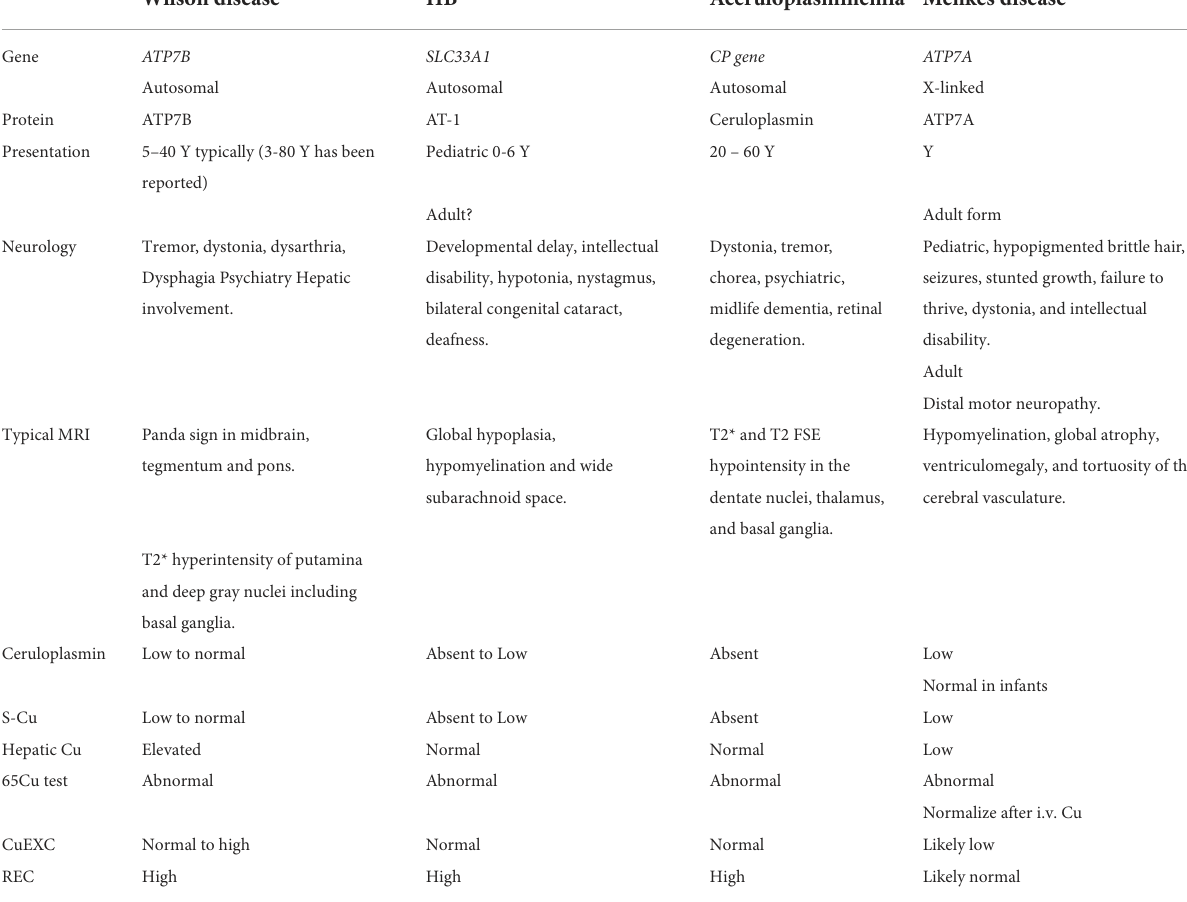
TABLE 1 Overview of Huppke–Brendel (HB) syndrome and other copper-related